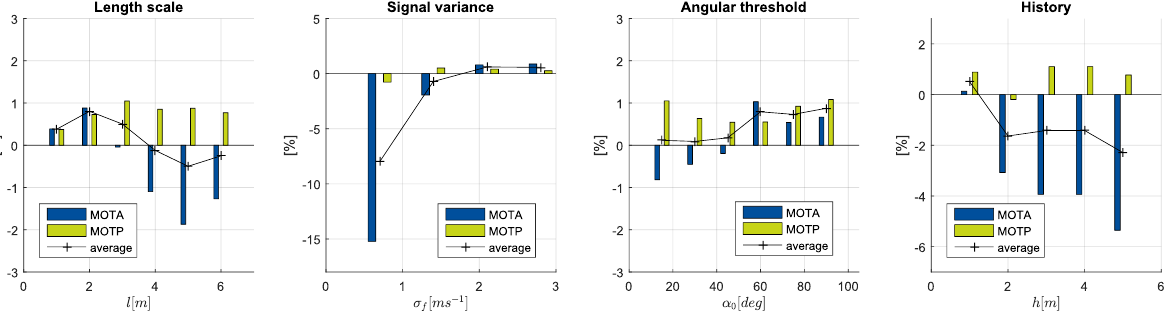
Figure 4. Variation of the parameters and difference of the sum of MOTA and MOTP metrics relative to the results from the stand-alone Kalman